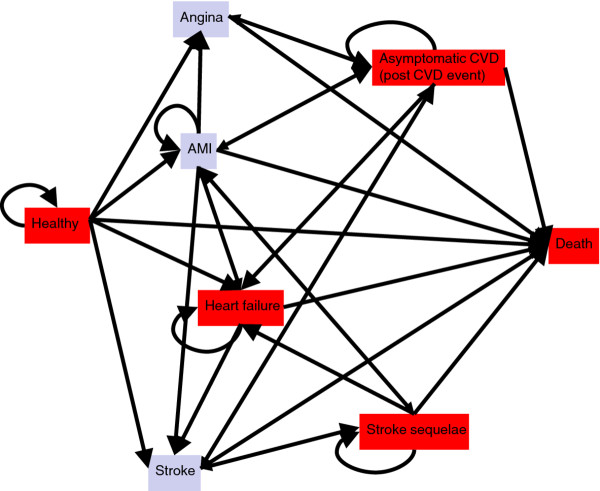
Model structure.